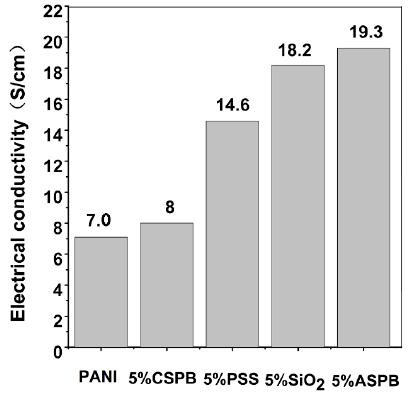
Figure 7. Pictures of the room-temperature electrical conductivity of PANI, PANI/ASPB, PANI/PSS, PANI/CSPB, and PANI/SiO 2 nanocomposites.